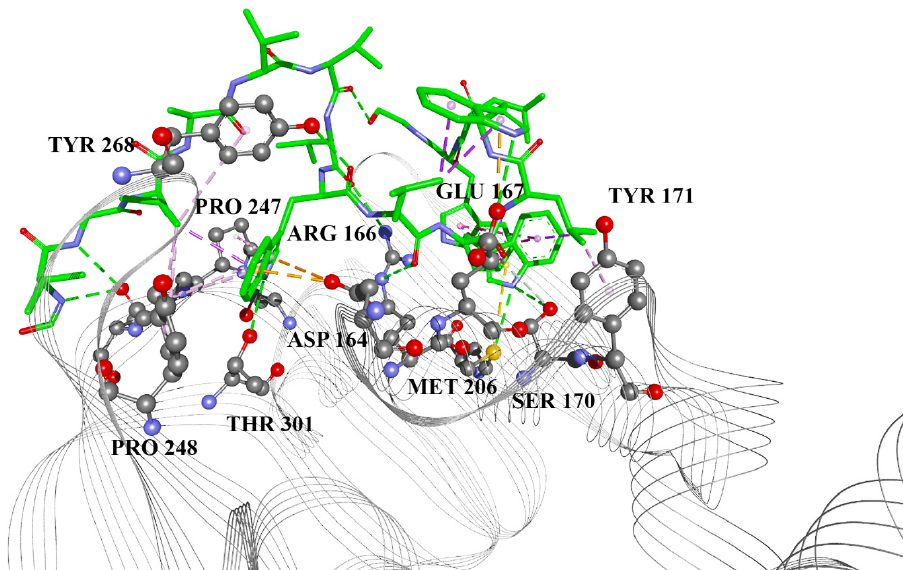
Figure 1. Gramicidin D docked into the catalytic site of PL pro . Green lines: hydrogen bonds; orange: electrostatic (including Pi-anion); yellow: Pi-sulfur; magenta: Pi-alkyl.